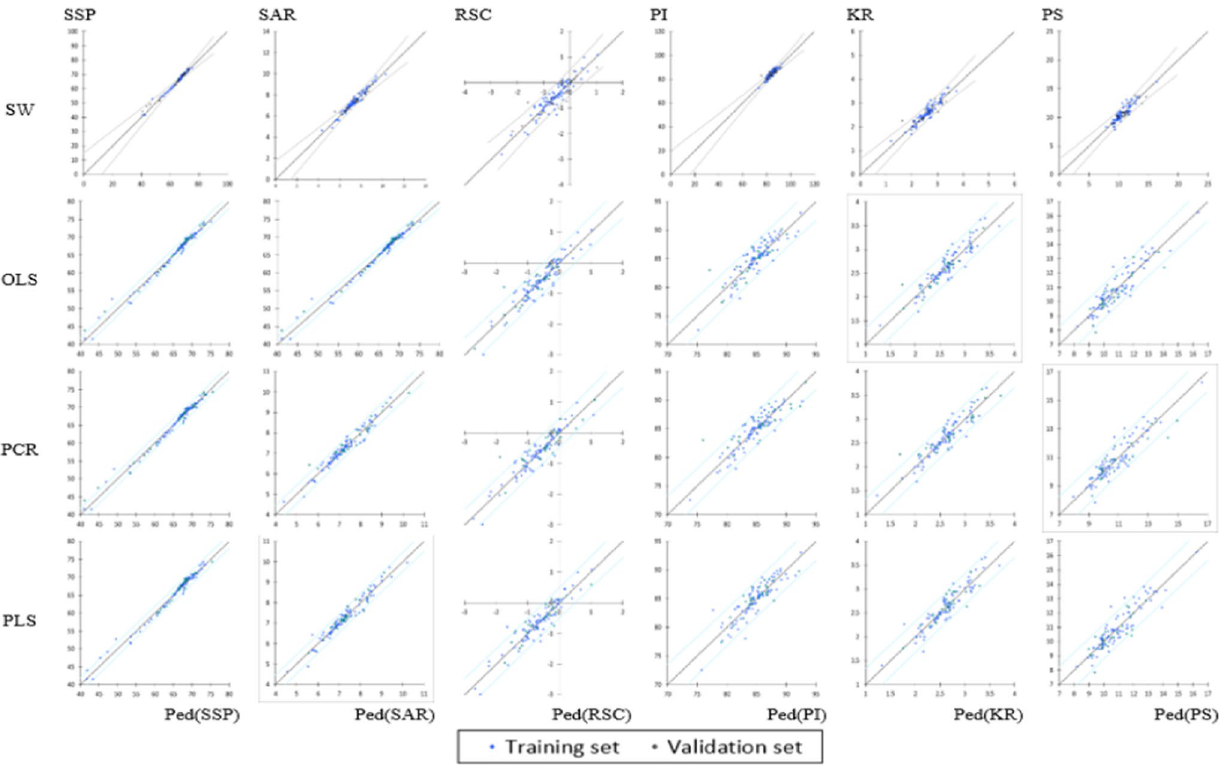
Fig. 4 Scatterplots of the estimated and calculated values of the IWQIs for the applied models (SW, OLS, PCR and PLS)